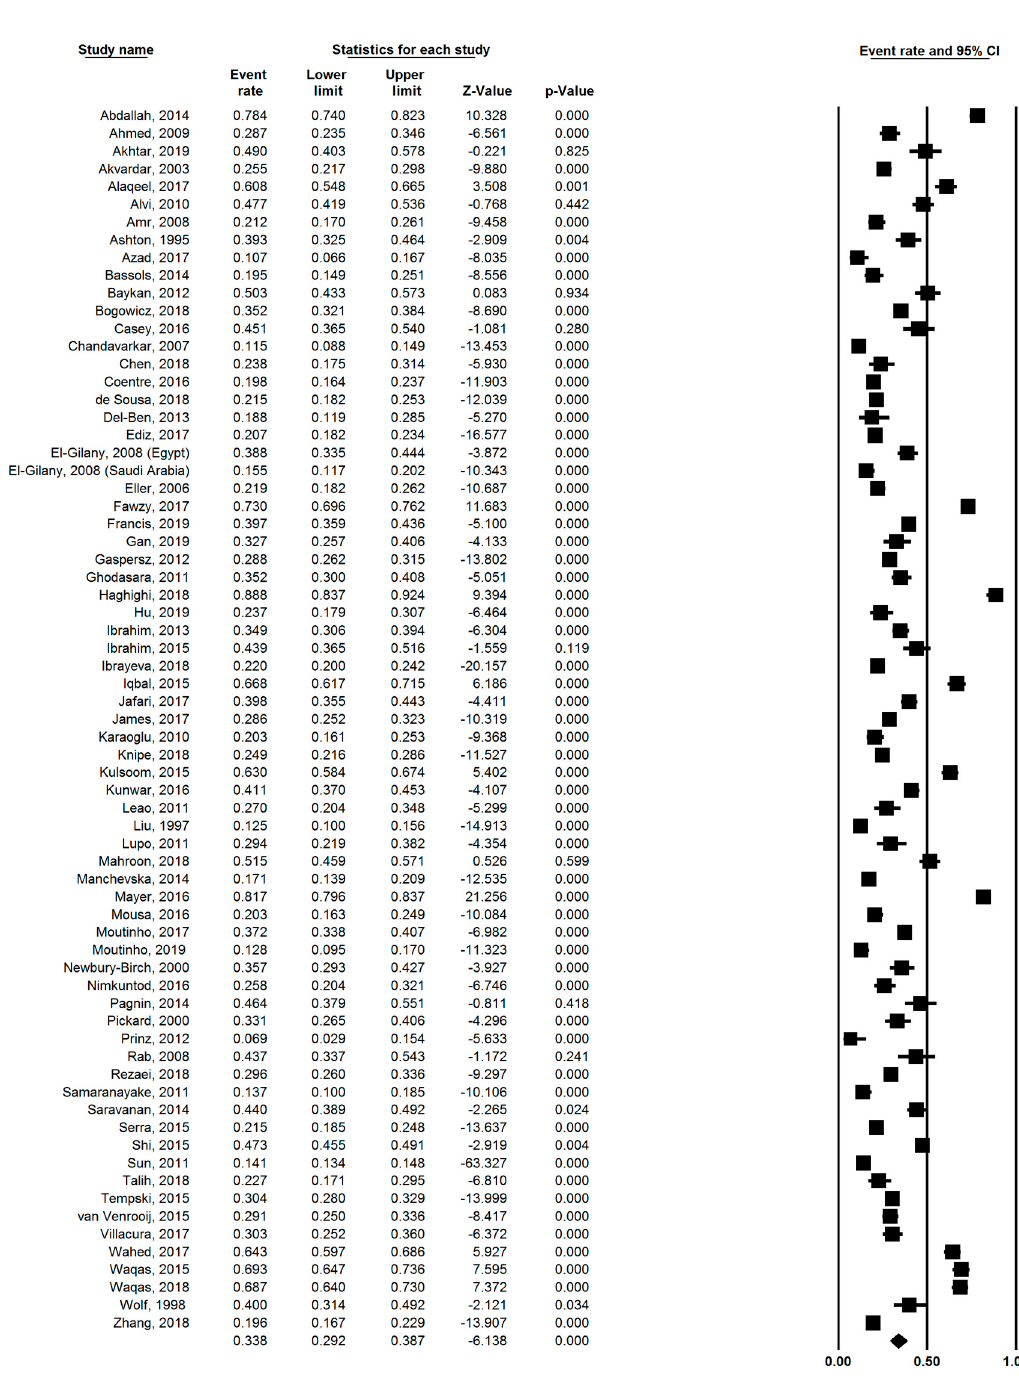
Figure 2. Forest plot of studies (n = 69) examining the prevalence of anxiety among medical students (n = 40,348). 95% CI: = 95% confidence interval.